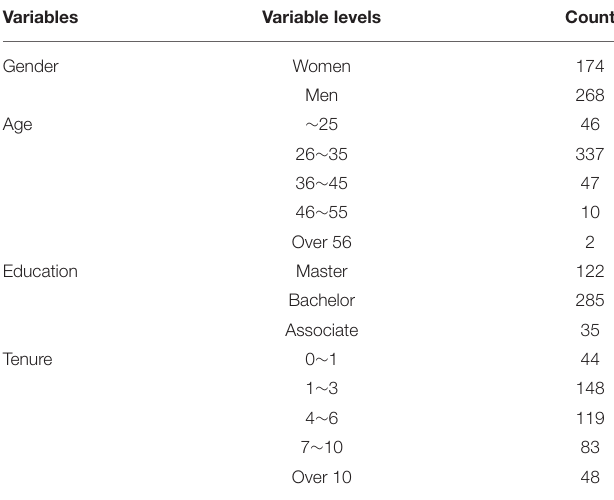
TABLE 3 | Frequency counts for categorical variables ( N =